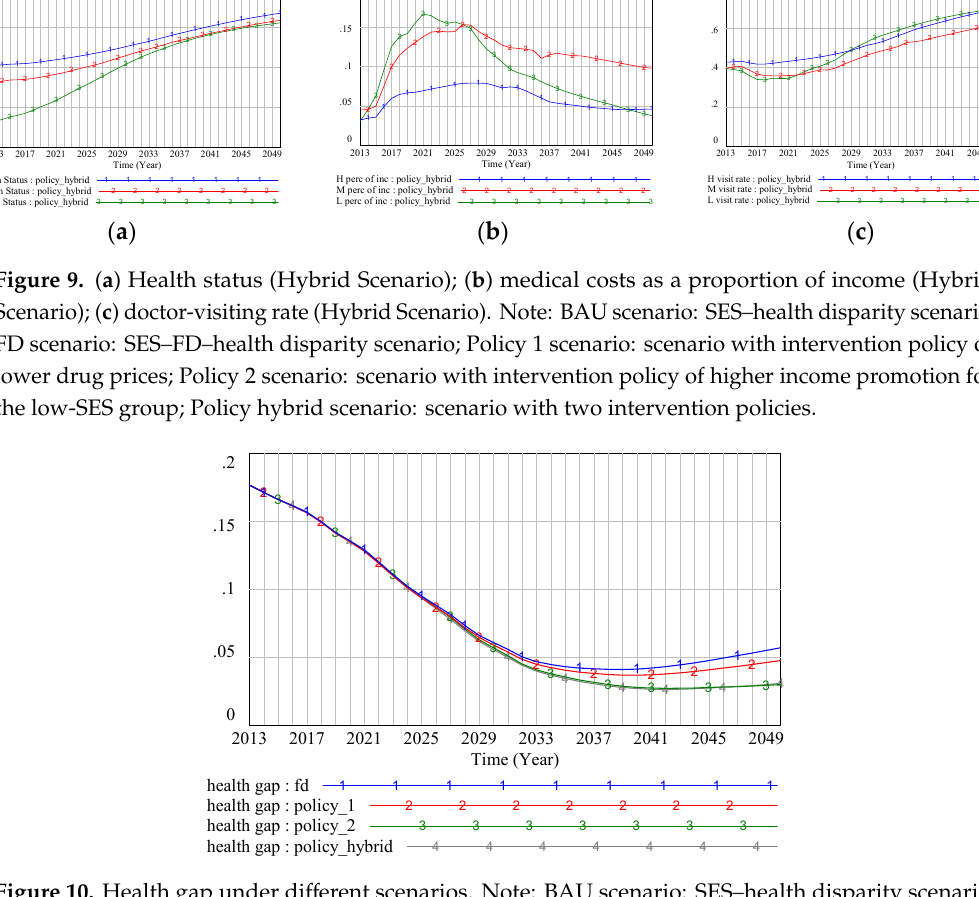
Figure 10. Health gap under different scenarios. Note: BAU scenario: SES–health disparity scenario; FD scenario: SES–FD–health disparity scenario; Policy 1 scenario: scenario with intervention policy of lower drug prices; Policy 2 scenario: scenario with intervention policy of higher income promotion for the low-SES group; Policy hybrid scenario: scenario with two intervention policies.